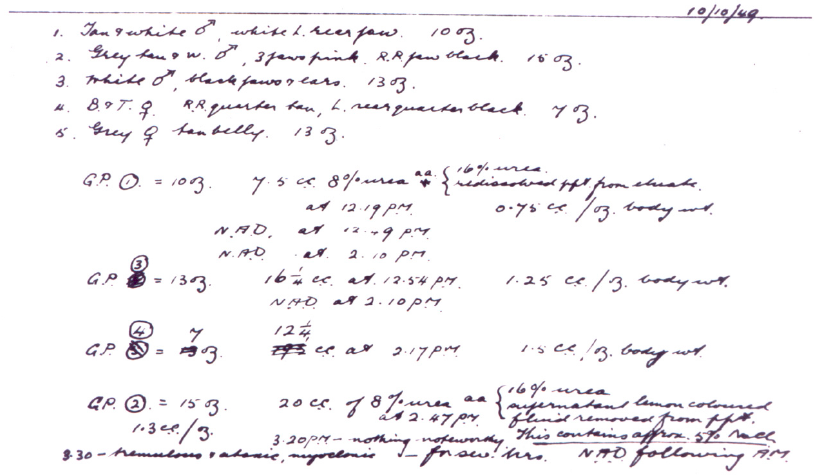
Figure 11. Laboratory notes by Cade regarding the effects of the injection of different compounds and lithium salts to guinea pigs.